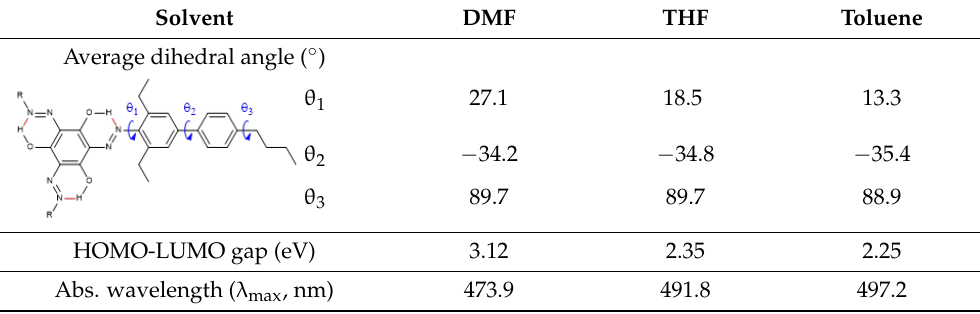
Table 2. Computationally obtained average dihedral angles, HOMO-LUMO gaps, and absorption wavelengths depending on solvent medium. Inset: Two-dimensional structural skeleton of 3Bu, where intramolecular hydrogen bonds are red-colored and three torsional angles are blue-colored. Solvent DMF THF Toluene Average dihedral angle ( ◦ )